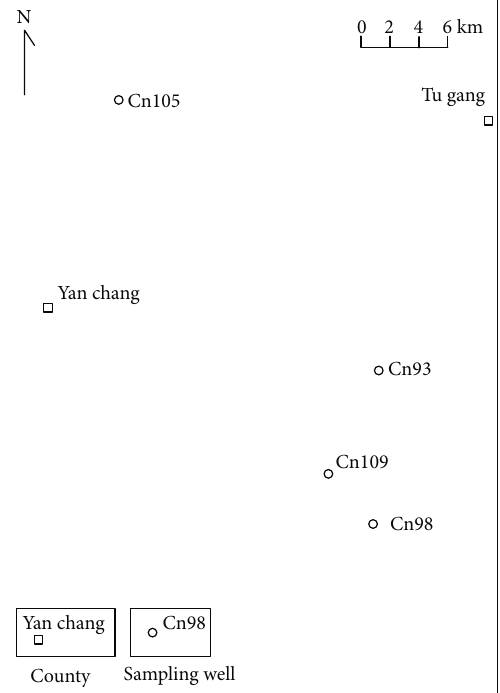
Figure 2: Location of sampling wells in Yanchang area.